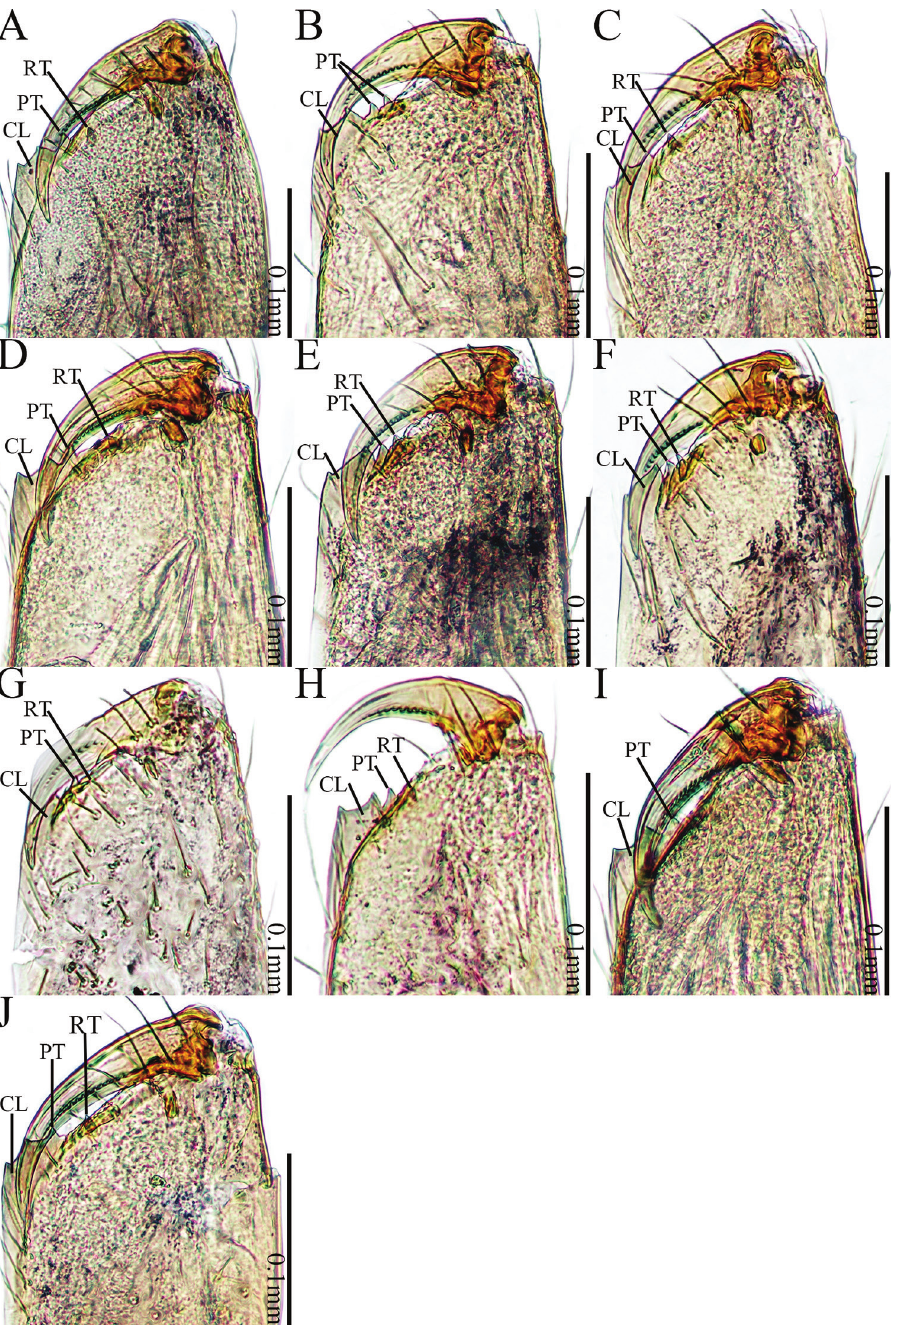
Figure 21. Cheliceral retromargin A Sinoderces khanensis sp. nov. B S. luohanensis sp. nov. C S. phathaoensis sp. nov. D S. dewaroopensis sp. nov. E S. xueae sp. nov. F S.taichi sp. nov. G S. wenshanensis sp. nov. H S. aiensis sp. nov. I S.saraburiensis sp. nov. J S. kieoensis sp. nov. Abbreviations: RT retromargin teeth, PT promarginal teeth, CL cheliceral